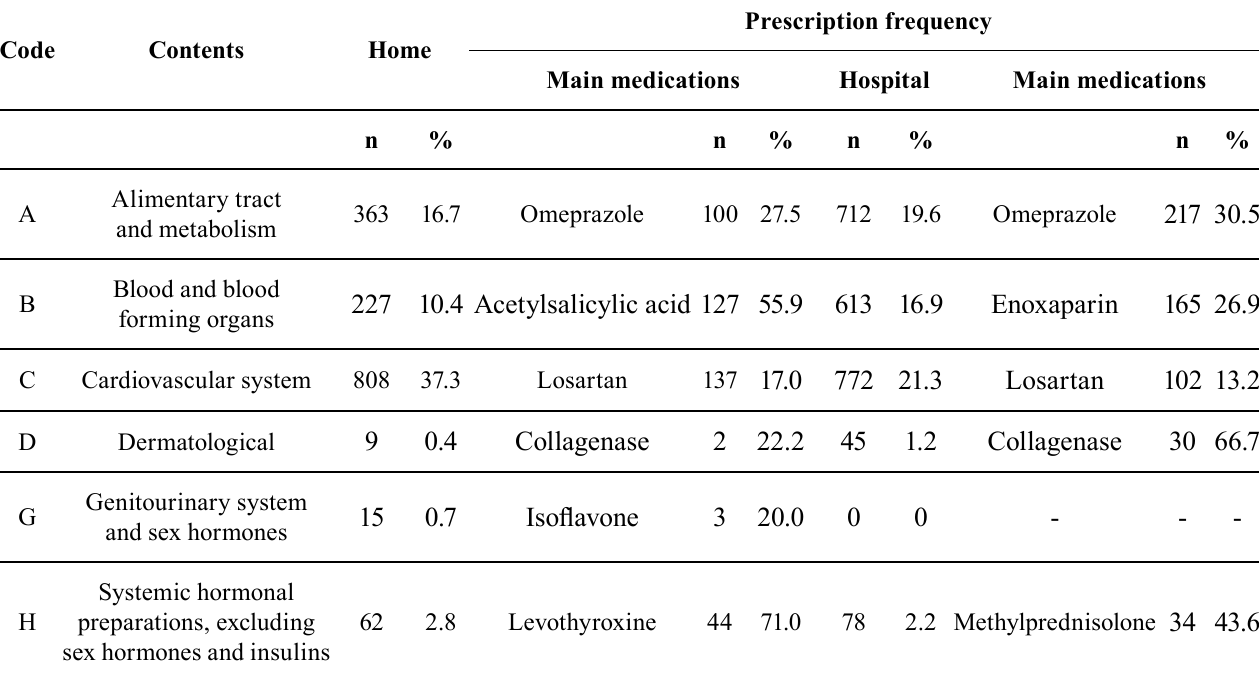
TABLE II – Most frequently prescribed drugs of the classes used in the home and hospital prescriptions by study participants hospitalized in the period from 2015 to